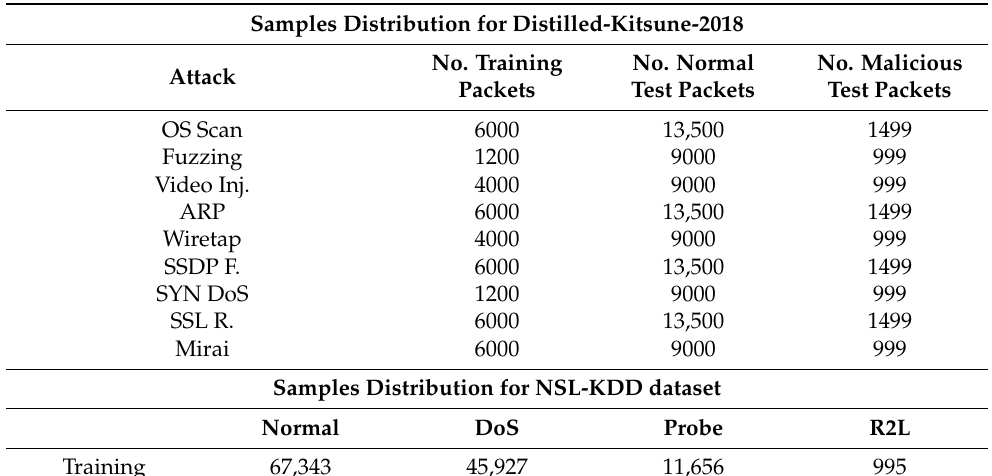
Figure 3. Confusion matrix with other performance evaluation measures. Table 4. Summary of Dataset Distribution: distilled-Kitsune-2018 and